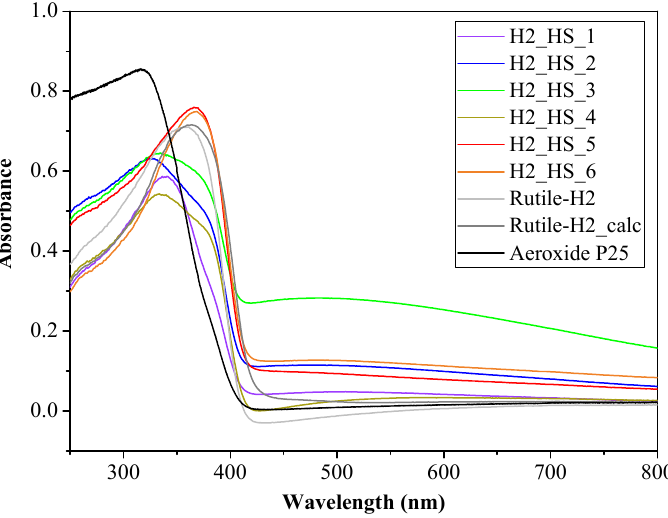
Figure 9. Diffuse reflectance (DR) spectra of the investigated TiO 2 -s.